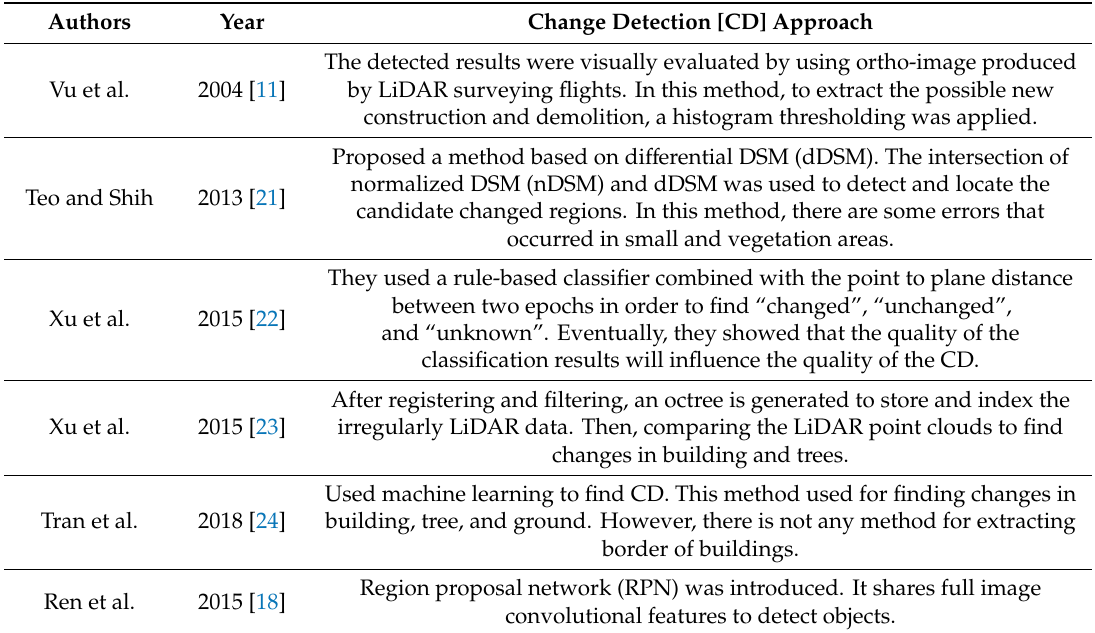
Table 1. List of proposed change detection using airborne light detection and ranging (LiDAR) data.